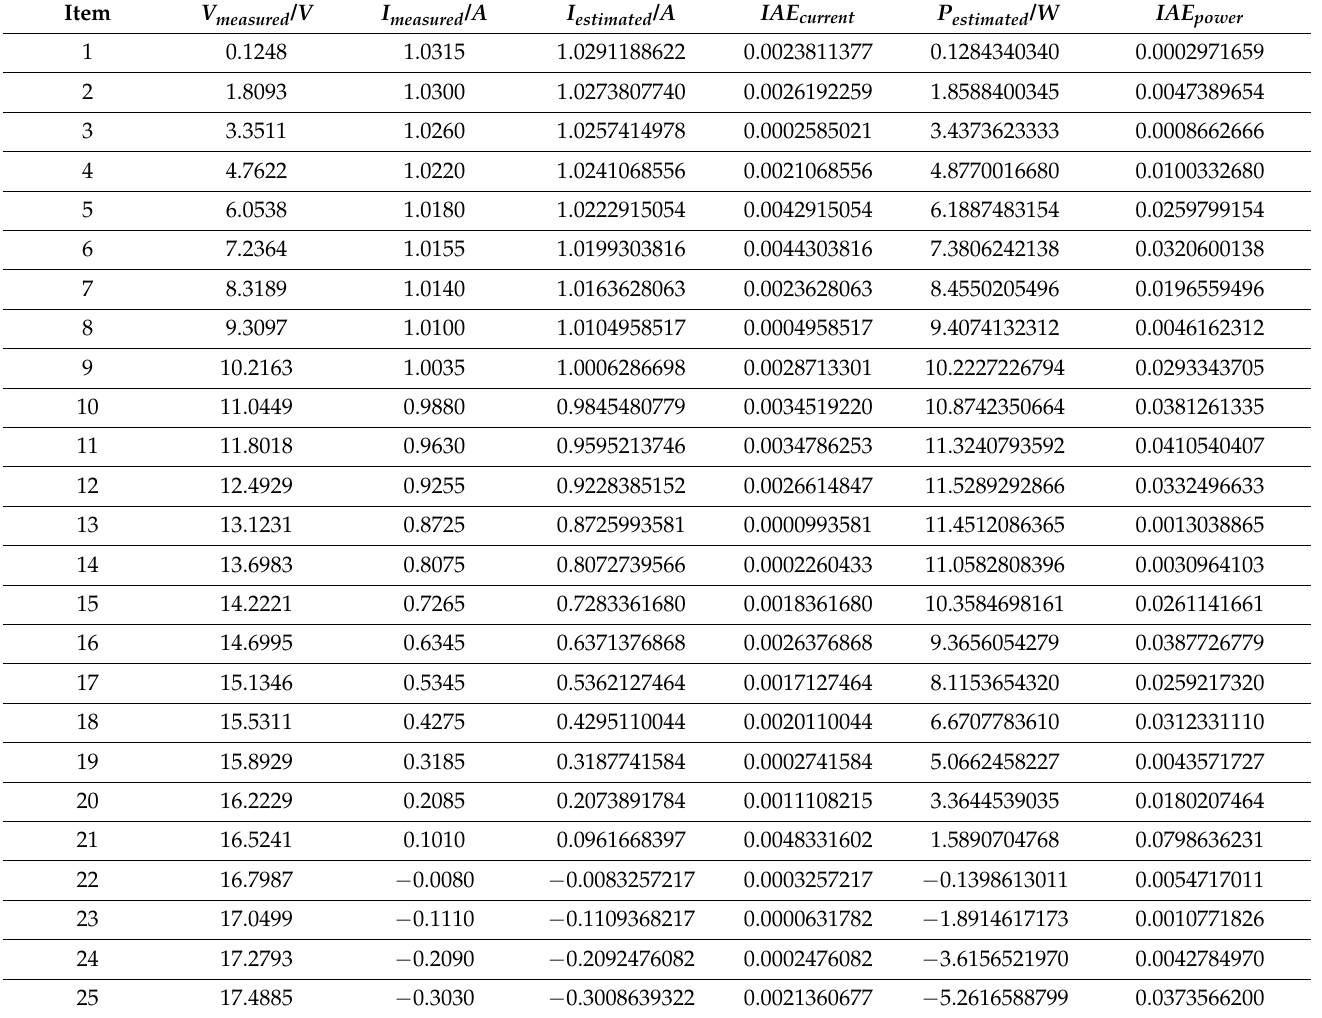
Figure 7. Experimental and calculated data of CSOOJAYA for PV module. Table 10. IAE of CSOOJAYA for PV